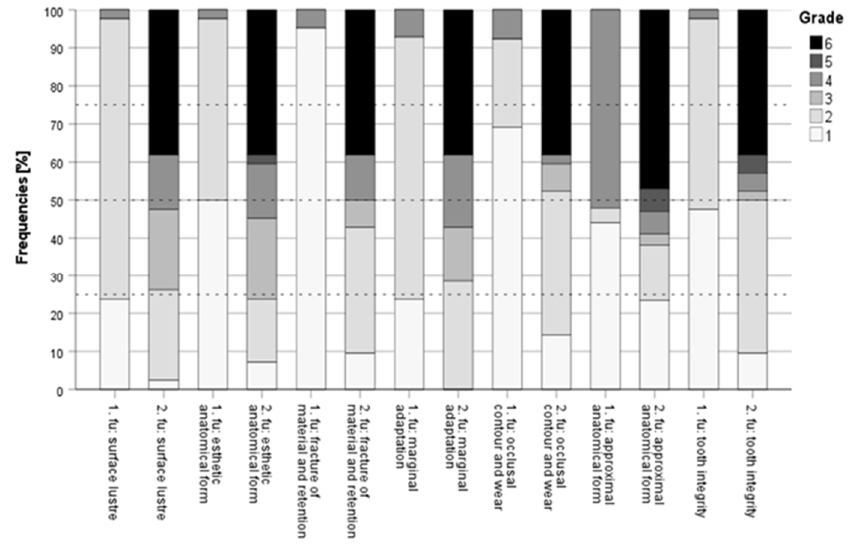
Figure 3. Stacked bar charts with median and first and third quartile for 22 patients and 42 restora- tions at the first follow-up (1.fu) and the second follow-up (2.fu)